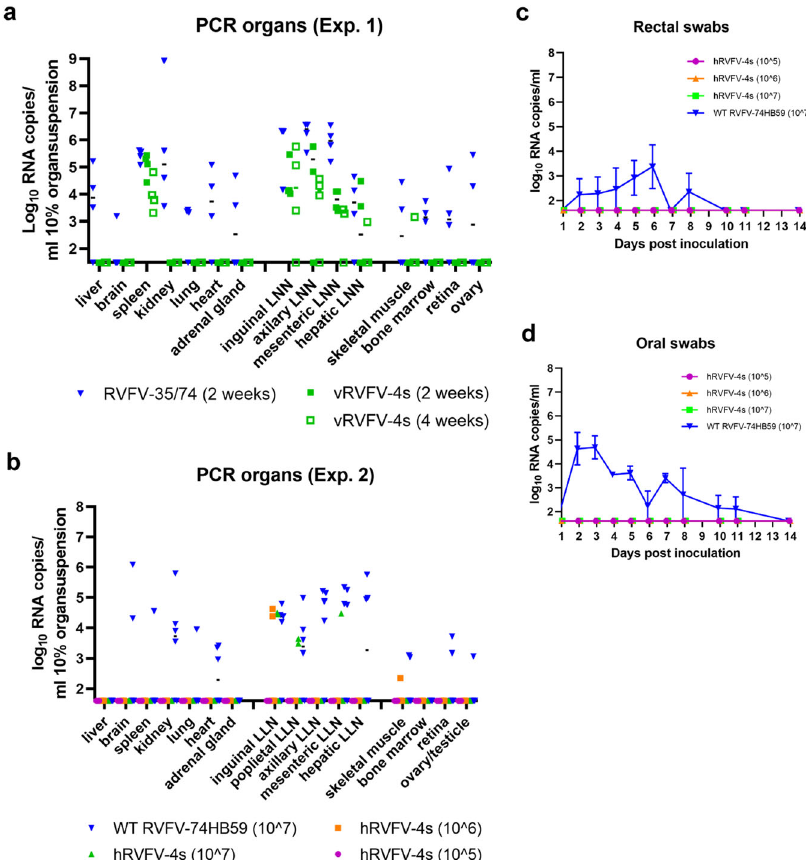
Fig. 6 RVFV-4s does not disseminate to RVFV target organs, while the virus is most likely carried by phagocytes to lymphoid organs. Organ suspensions of marmosets from experiment 1 ( a ) and experiment 2 ( b ) as well as rectal ( c ) and oral swabs ( d ) of animals from experiment 2 were assessed for the presence of viral RNA by RT-qPCR. The x -axes cross the y -axes at the limit of detection (1.48 log10 RNA copies/ml for experiment 1 and 1.6 log10 RNA copies/ml for experiment 2). c , d Averages and SEM are presented for each